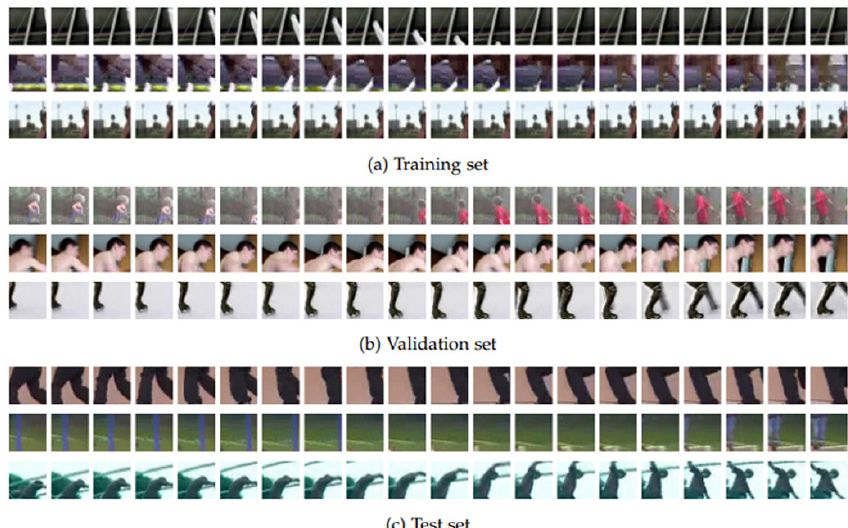
Fig. 7. Sequence examples from UCF-101. These frames have been randomly selected from the different splits, cropped to 32 × 32, and filtered to ensure they contain at least a small proportion of